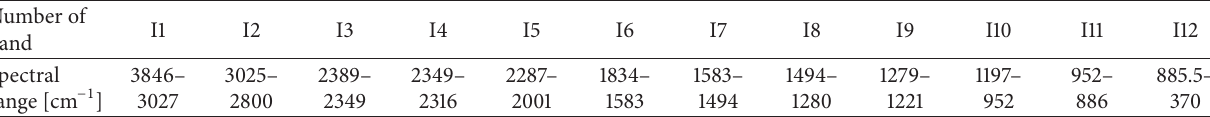
Table 4: Spectral ranges used for CSR and PLS